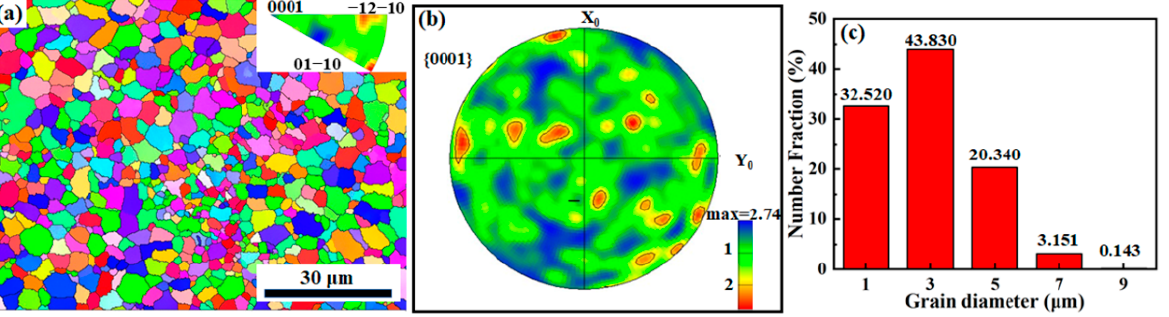
Figure 6. EBSD of AS41 Mg alloy sample along the cross-section: ( a ) the grain orientation and inverse polar map, ( b ) the polar figure, ( c ) the grain size distribution.